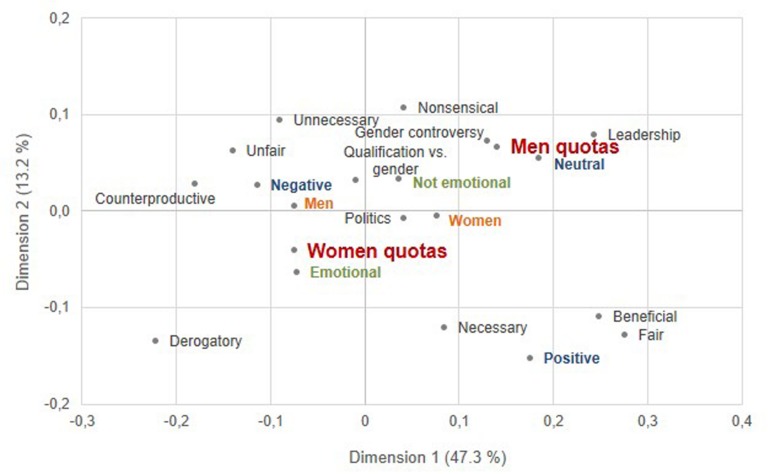
Biplot of the multiple correspondence analysis with the stimuli women quotas and men quotas (red), participant gender (orange), association valence (blue), association emotionality (green), and association category (gray). The biplot is interpreted by examining the position of the variables (i.e., gender, valence, emotionality) and the semantic content (i.e., the categories) along Dimension 1 and 2 (Greenacre and Blasius, 2006). In addition, the spatial distance between the variables and the semantic content reflects their relationships to each other. The closeness of points to each other represents the frequency of connections in the data (Abdi and Valentin, 2007).